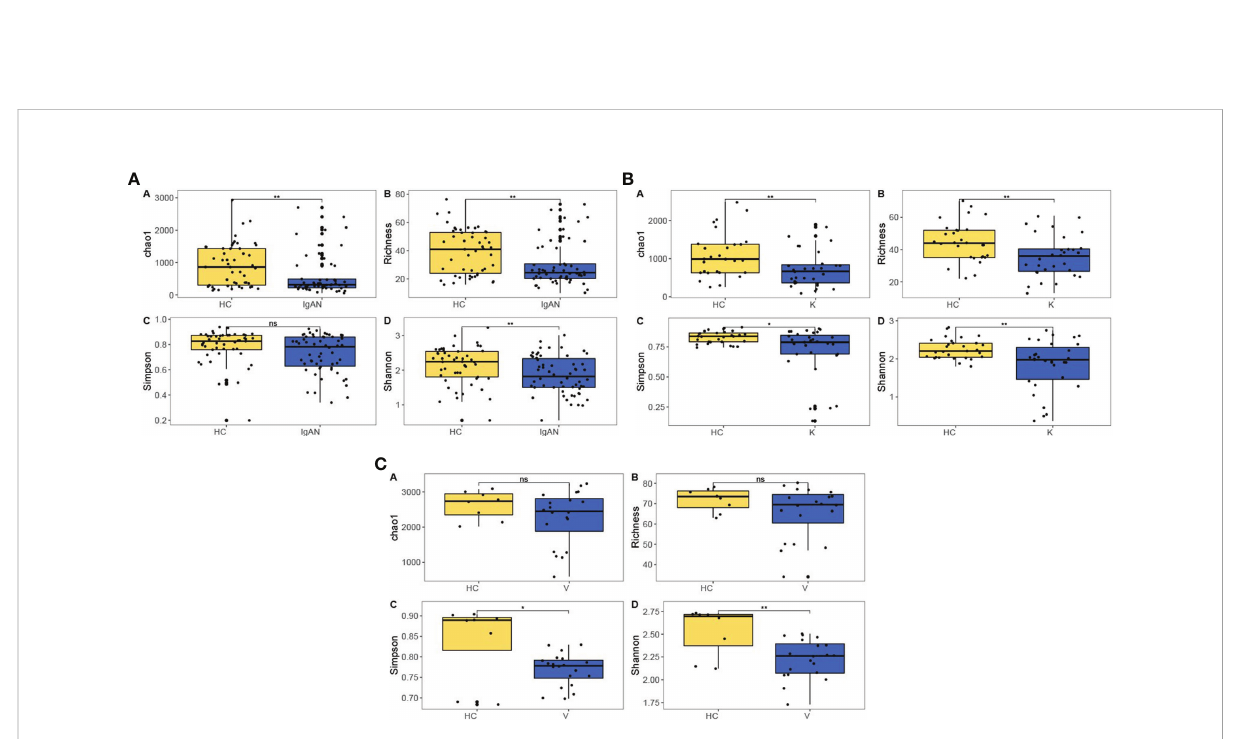
FIGURE 3 Intestinal fl ora richness and diversity in IgAN (A) , KD (B) and IgAV (C) . *P<0.05, **P<0.01, ns (no signi fi cance)